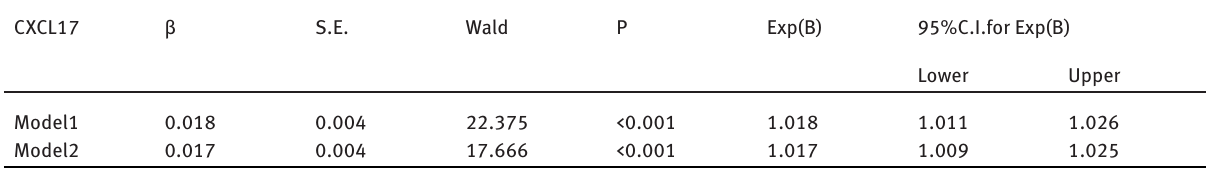
Table 3: Logistic regression analyses of association between serum CXCL17 levels and unstable angina.